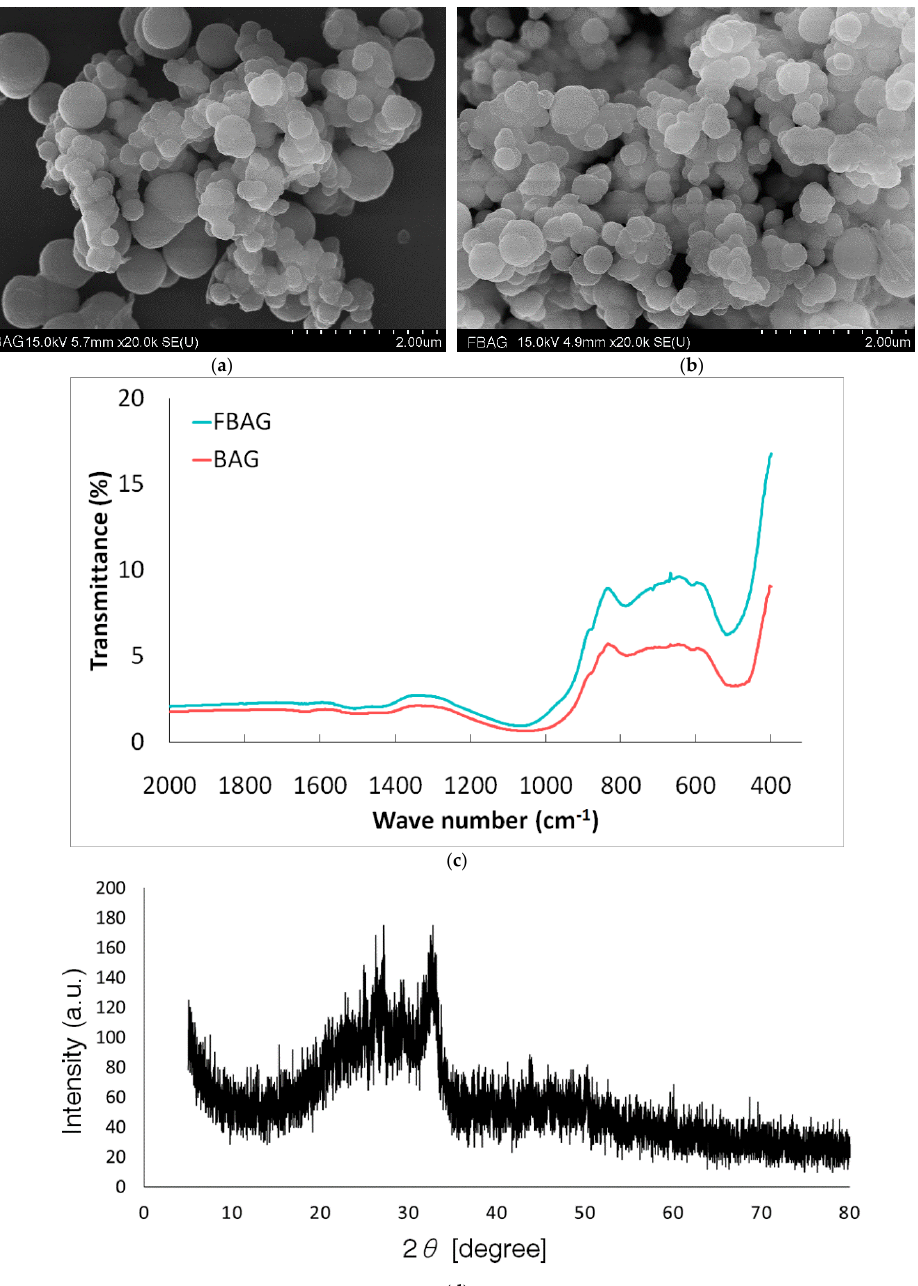
Figure 3. BAG and FBAG characterization. ( a ) SEM image of BAG; ( b ) SEM image of FBAG; ( c ) FTIR spectra of BAG and FBAG; ( d ) XRD patterns of BAG.